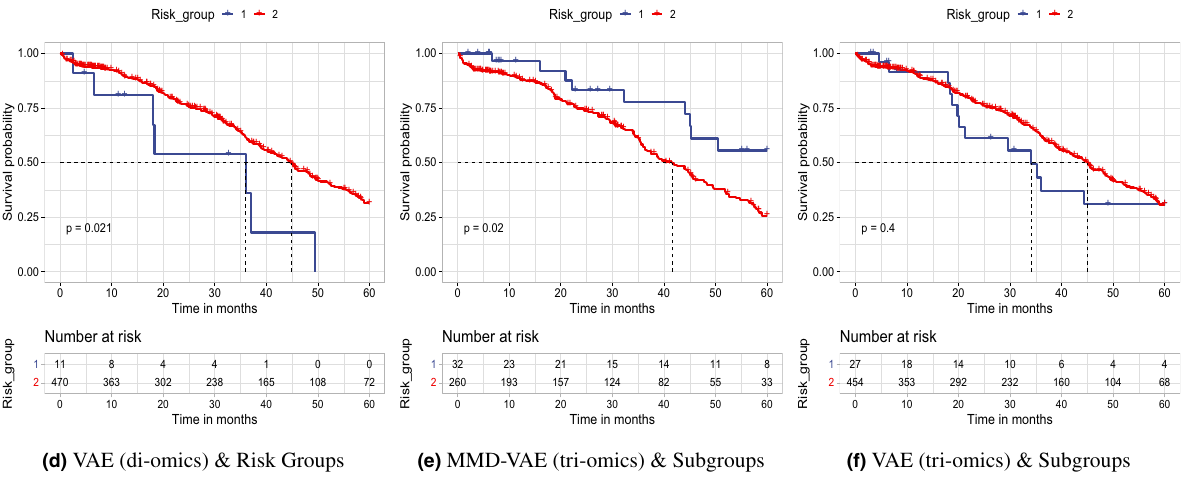
Figure 4. Survival analysis using existing using molecular subtypes and CRLFs-based survival subgroups: ( a ) survival analysis using the existing transcriptional subtypes show that they are not linked to the survival ( p = 0.19 < 0.05 ), ( b – f ) survival analysis using the two subgroups show significant survival differences ( p < 0.05 ) between the groups. The results in ( e ) for 292 samples, and the rest are for 481